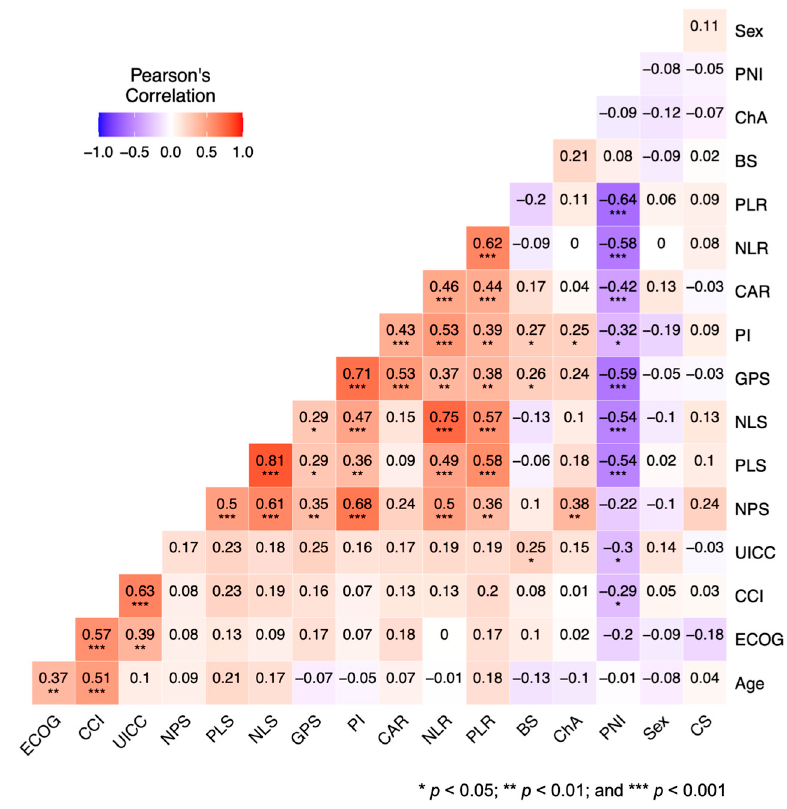
Figure 2. Visualization of Pearson’s correlation with respect to the clinical characteristics and inflammation-/nutritional-status-based risk scores/ratios. High degrees of correlation are colored in red and low degrees of correlation are colored in blue. Significant correlations are marked with * ( p < 0.05), ** ( p < 0.01), and *** ( p < 0.001).